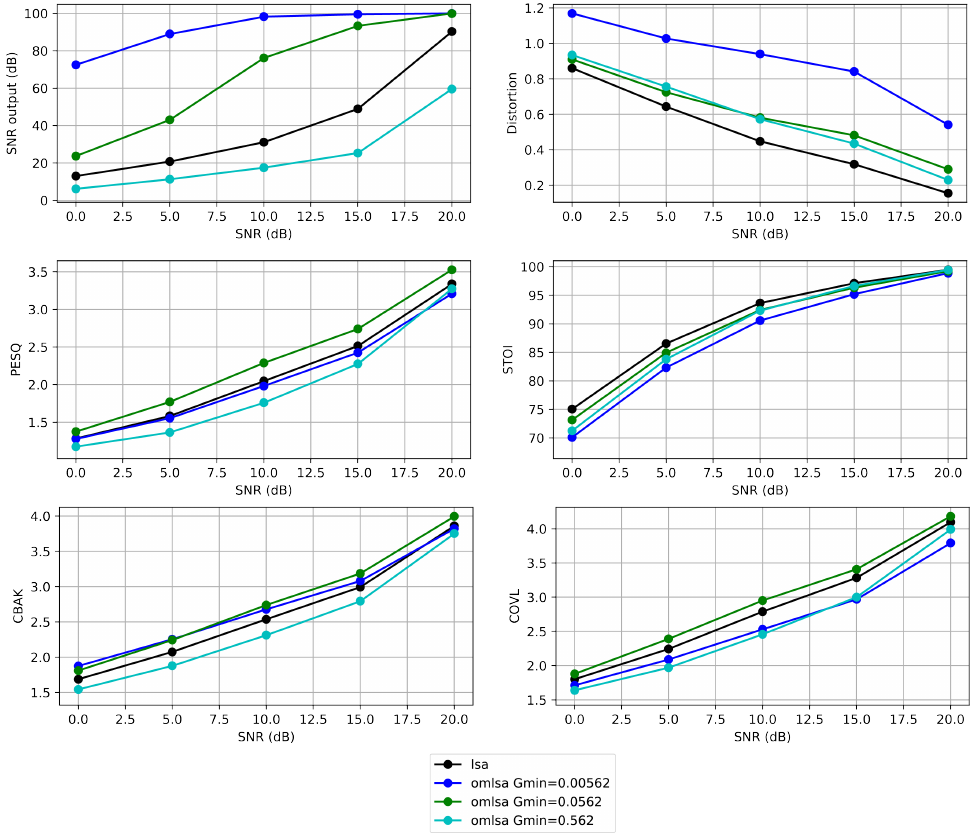
Figure 3. SNR, distortion, PESQ, STOI, CBAK and COVL for LSA and OMLSA speech estimators averaging throughout all